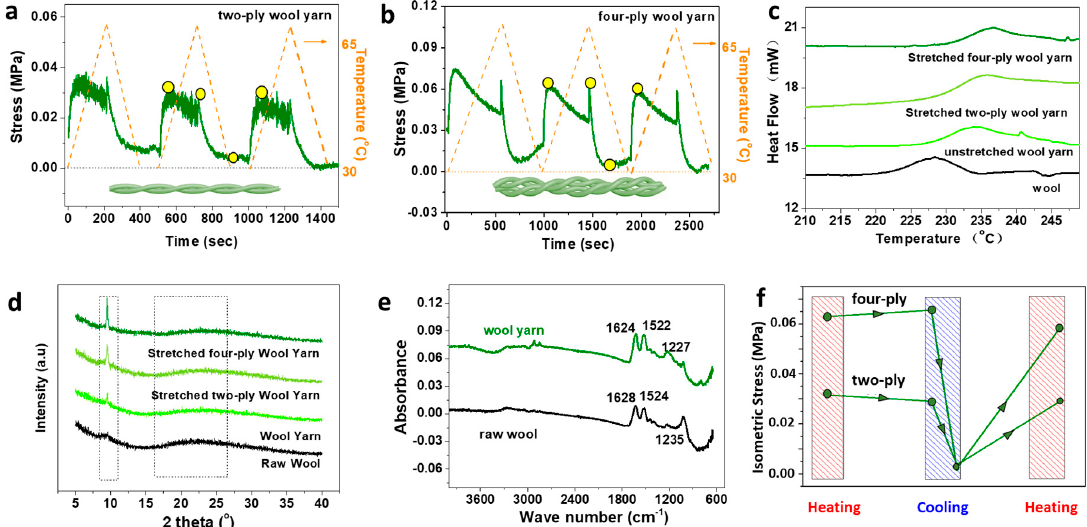
Figure 3. Isometric contraction of ( a ) two-ply wool yarn and ( b ) four-ply wool yarn. ( c ) Differential scanning calorimetry (DSC), ( d ) X-ray diffraction (XRD) pattern and ( e ) Fourier transform infrared (FTIR) of samples with and without stretching. ( f ) Evaluation of stress evolution: adopted data were acquired from marked points as shown in Figure 3a,b (yellow circles).